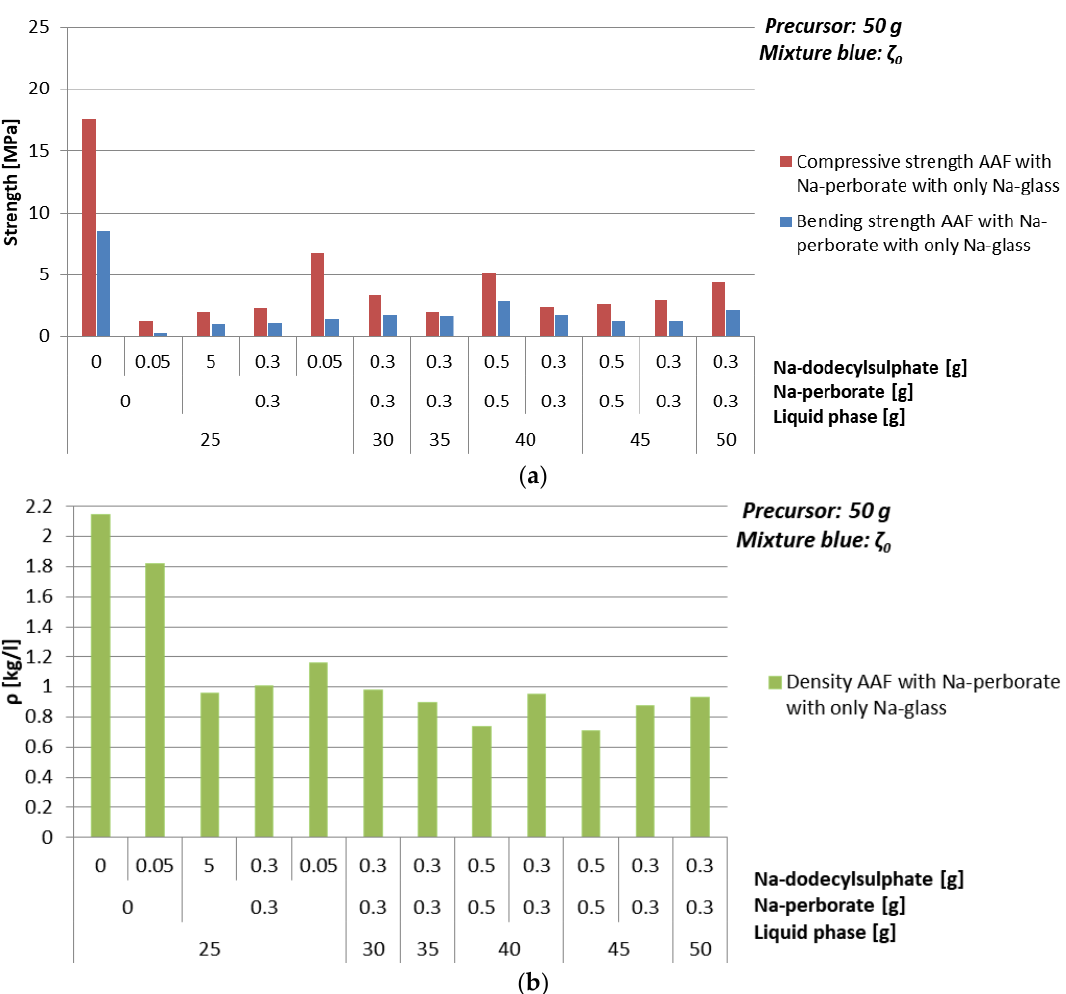
Figure 16. ( a ) Bending and compressive strength, and ( b ) density of AAF, produced by Na-perborate using mixture ζ 0 , cured on 70 °C for one day, measured one week after molding.